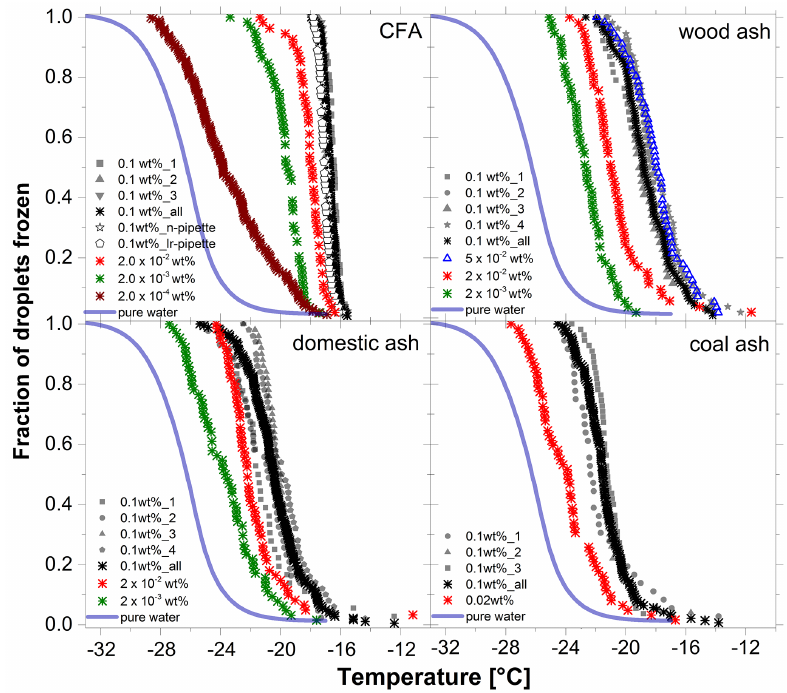
Figure 5. Fraction of droplets frozen ( f ice ) from freezing experiments in the µL-NIPI. Each panel shows freezing curves of droplets con- taining known concentrations (wt%) of CFA, wood, domestic and coal bottom ashes. In all the panels, a fit to the background freezing (blue line) of ultra-pure water (18.2M (cid:127) cm resistivity) is plotted. All plots labelled as “0.1wt%_all” on every panel are cumulative fractions frozen obtained from many repeat experiments. n-pipette represents normal pipette tips and lr-pipette is for low-retention pipette tips. All experiments shown in this figure were performed with the n-pipette except indicated. The temperature uncertainty for µL-NIPI is quoted as ± 0.4K for all measurements and it is not plotted with the data points for the purpose of